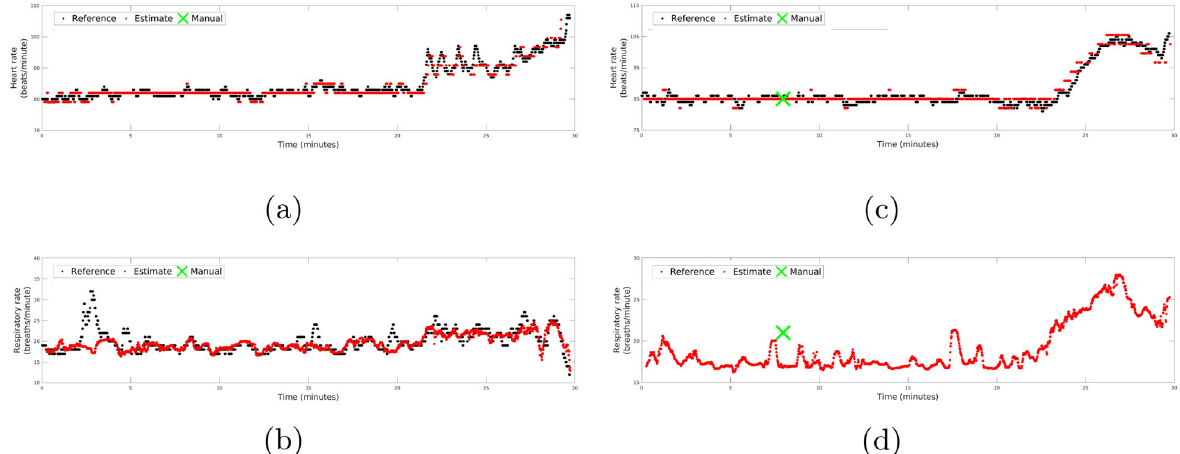
Fig. 3 Reference and video camera-derived traces for two 30-min sample periods. Heart rate and respiratory rate values for the fi rst period are shown in panels ( a ) and ( b ), respectively. Heart rate and respiratory rate values for the second period are shown in panels ( c ) and ( d ), respectively. Reference values were provided by the patient monitoring equipment (black), and manual nursing estimates (green). Fluctuations in heart rate associated with patient movement can be observed in ( a ) from t = 21 min to t = 25 min. The second 30-min sample ( c , d ) documents a period of deterioration from t = 20 min. The camera system produced frequent observations of both vital signs in during the episode of clinical deterioration. Only one manual respiratory rate was recorded during this period, as the impedance system was